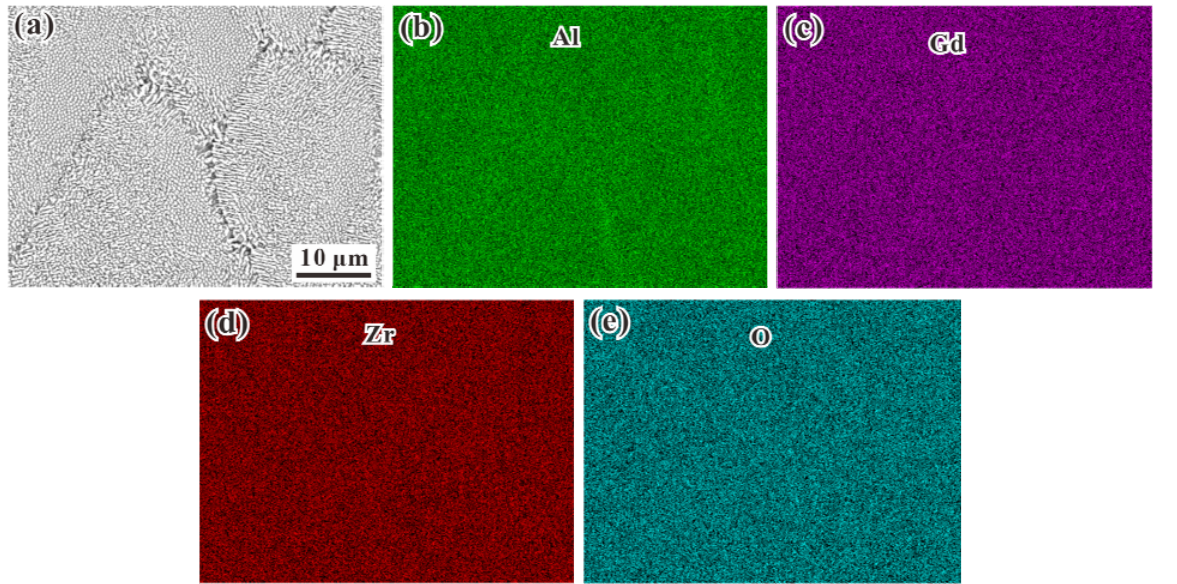
Fig. 5 Microstructural EDS mappings of the laser 3D-printed Al 2 O 3 /GdAlO 3 /ZrO 2 eutectic ceramic: (a) solidification microstructure, (b) distribution of Al, (c) distribution of Gd, (d) distribution of Zr, and (e) distribution of